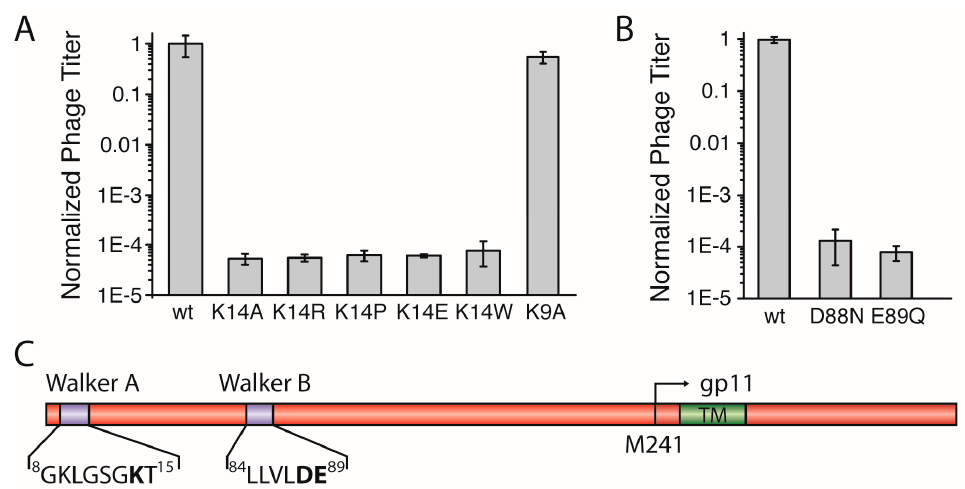
Figure 2. ( A ) Quantified phage titer in in vivo complementation assays of geneI mutants in the Walker A motif. The amount of phages produced using plasmid-encoded wild-type gp1 was normalised to 1 and compared with gp1 mutants, plotted on a logarithmic scale. The codon for lysine residue in position 14 (K14) in the putative Walker A motif was mutated to alanine (K14A), arginine (K14R), proline (K14P), glutamic acid (K14E), and tryptophan (K14W). None of the mutations can substitute for the lysine, indicating a crucial catalytic role of the residue contained within the motif. In addition, the effect of the mutation of lysine in position 9 to alanine (K9A) is shown on the right. The mutation in this position does not influence phage production. ( B ) In vivo complementation of geneI mutants in the putative Walker B motif. A mutation of the codon in position 88 from aspartate to asparagine (D88N) abolishes phage production. Similarly, the exchange of the residue glutamate to glutamine in position 89 (E89Q) results in the loss of phage production. ( C ) Schematic representation of the gp1 protein with its internal ORF g11p. The two Walker motifs, Walker A and Walker B, are shown in purple with the respective sequences below. Numbers indicate amino acid residues. Key residues crucial for phage production are in bold. The transmembrane (TM) segment is depicted in green.